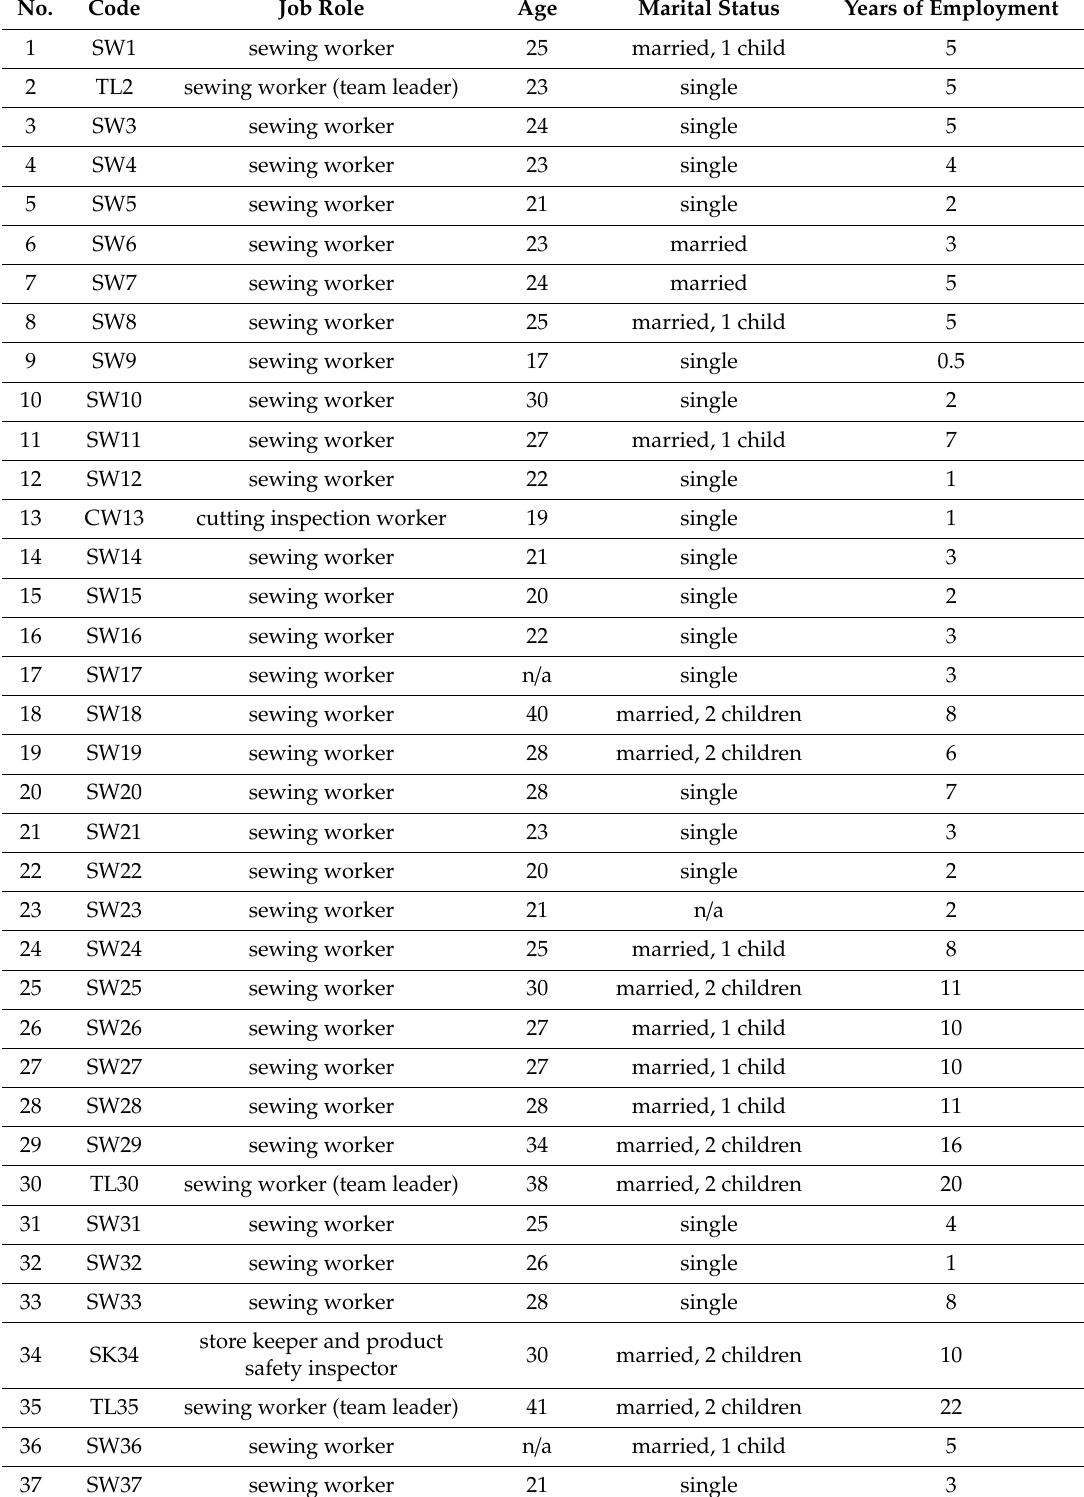
Table A1. Coding list of interviewed